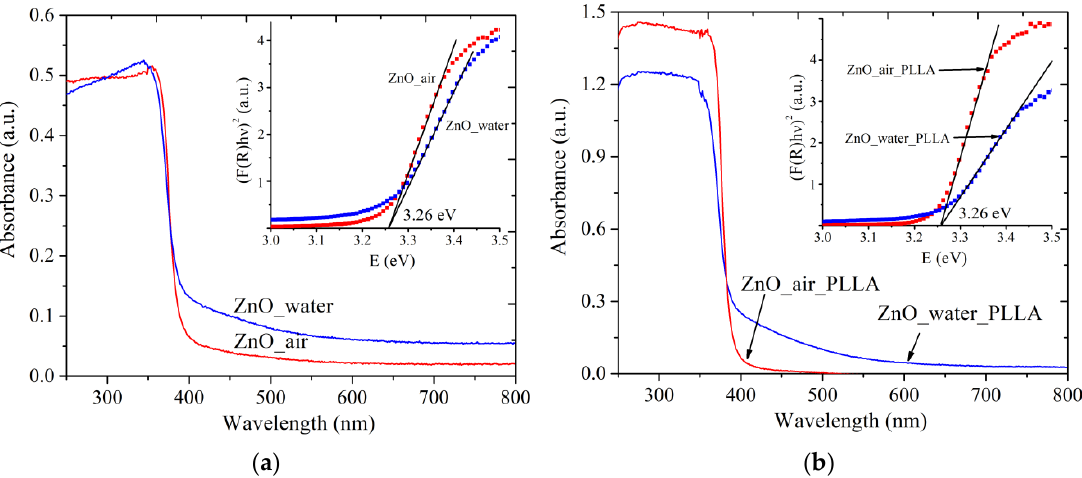
Figure 5. UV-Vis absorption spectra of powder samples ( a ) and ZnO-PLLA composites with NPs ( b ). Insets present how E g values were evaluated. Red and blue lines represent data for ZnO NPs produced in air and water, respectively.